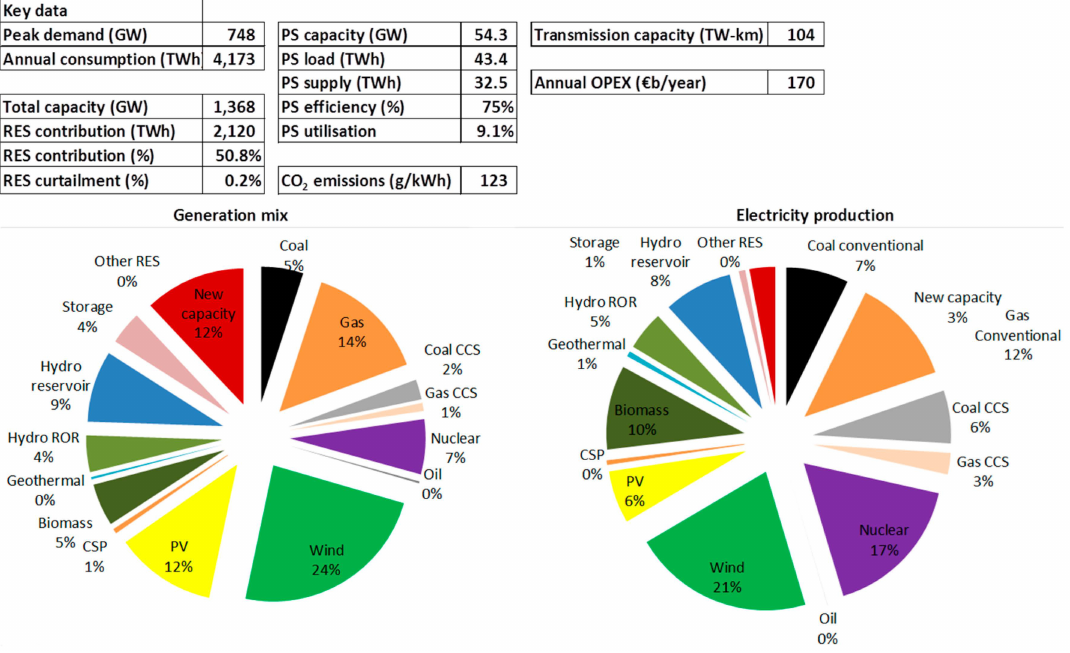
Figure A2. Low RES scenario for 2030.